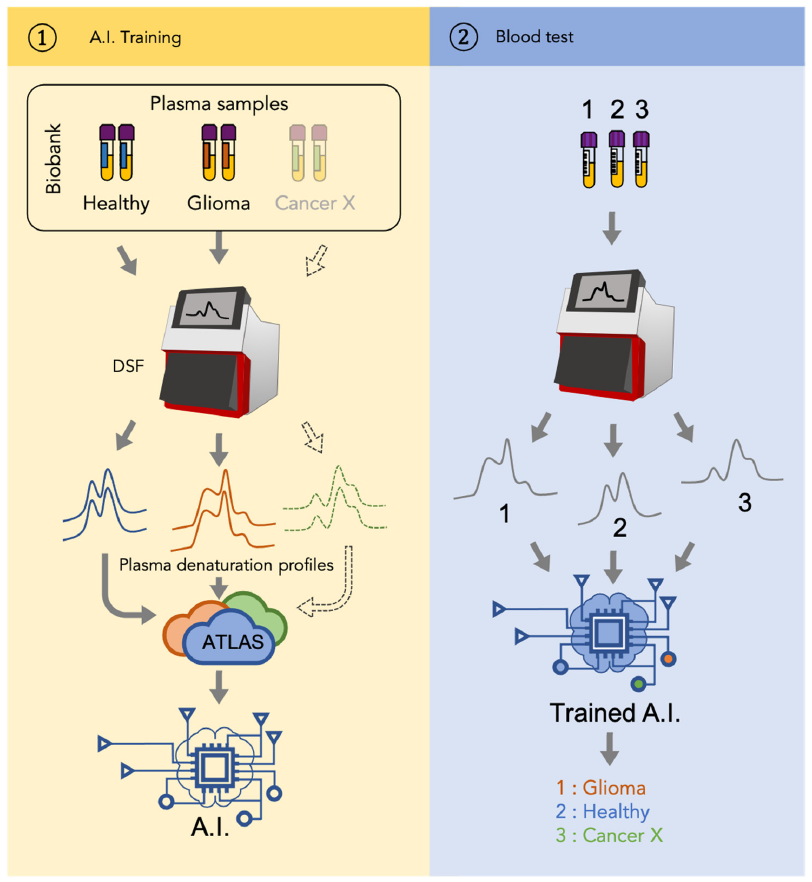
Figure 2. Patient-to-profile workflow/design of the study. Left panel corresponds with the training of machine learning. Denaturation profiles of plasma samples of healthy individuals and glioma